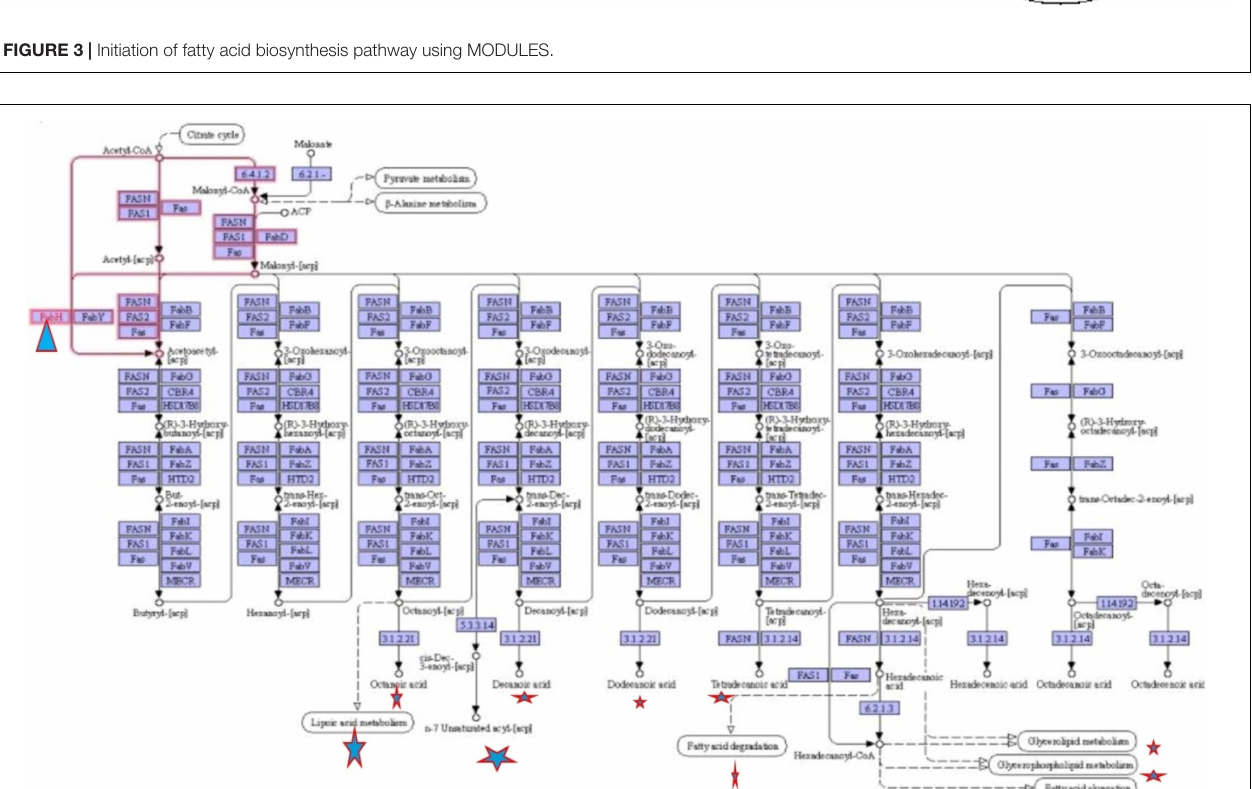
Frontiers in Microbiology |